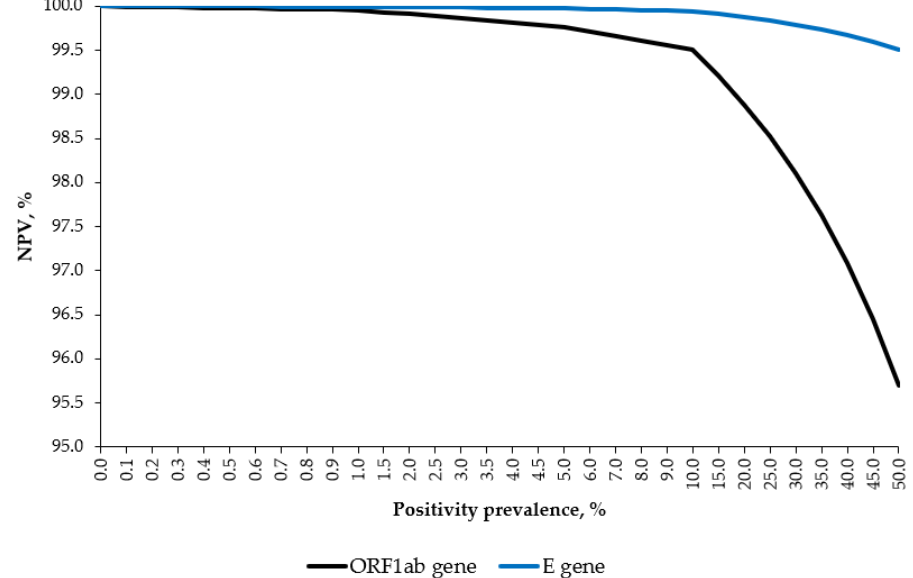
Figure 1. Negative predictive value (NPV) curves of the STANDARD M10 assay, by hypothetical prevalence and gene prevalence and gene target.